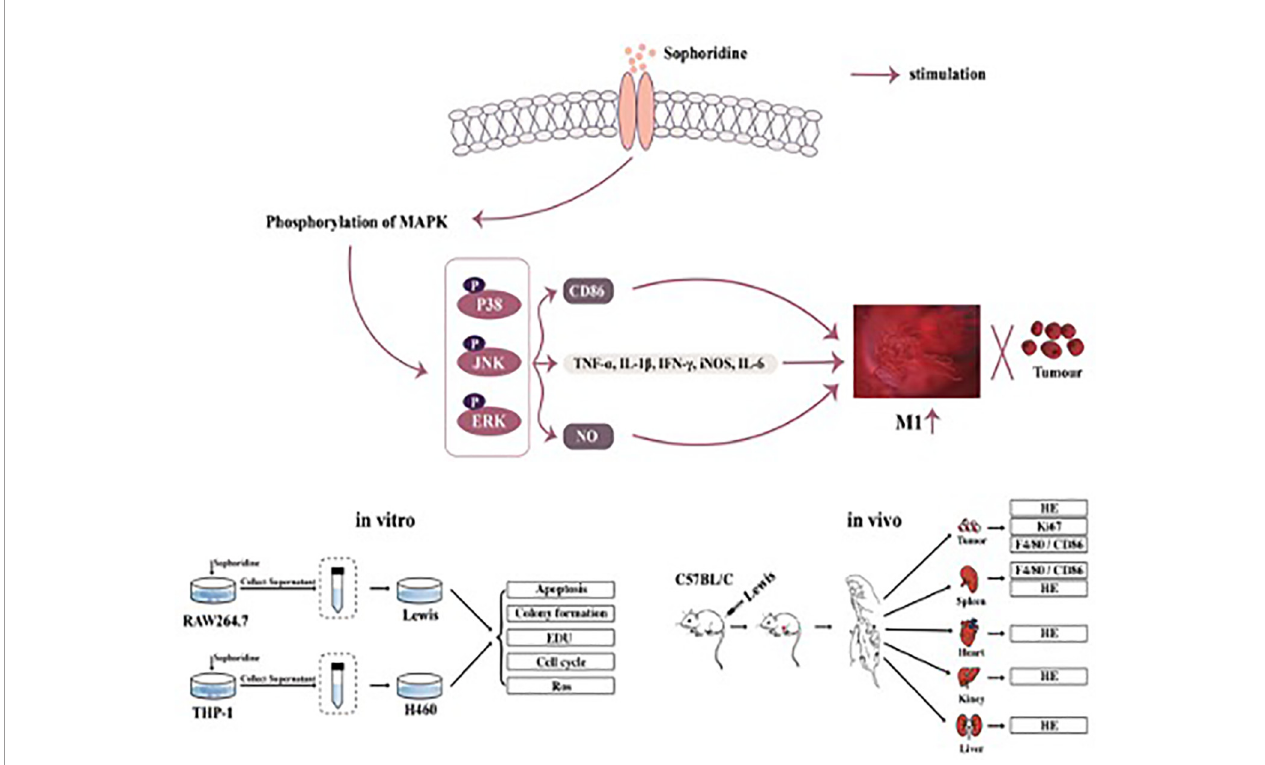
FIGURE 2 | Sophoridine induced macrophages M1 polarisation via MAPKs